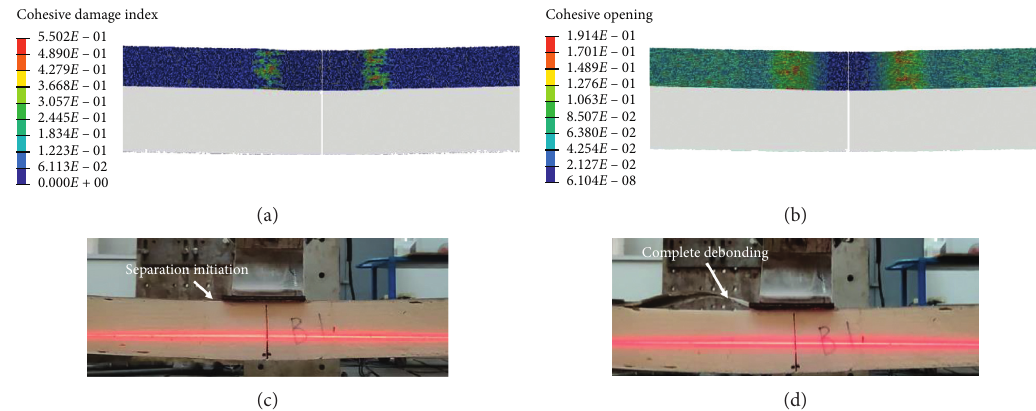
Figure 14: Damage localization recorded in measurement and the damage indicator predicted by uncertainty analysis: (a) damage indicator, (b) cohesive opening, (c) adhesive failure initiation, and (d) adhesive complete failure.